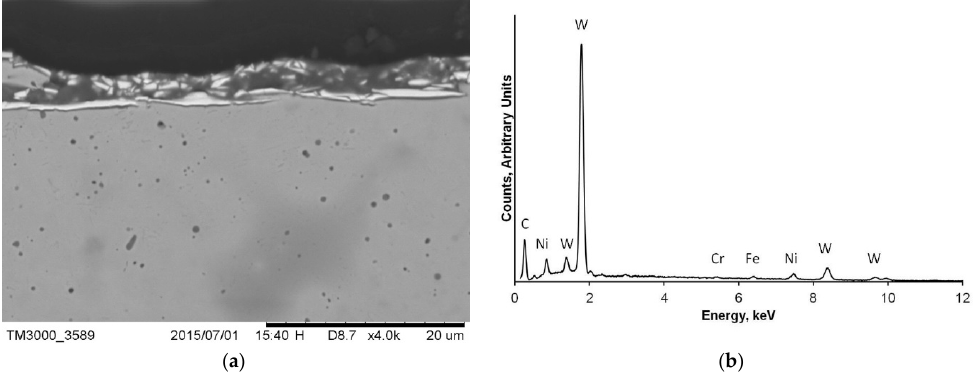
Figure 6. ( a ) Drill D section, which evidenced the tungsten carbide coating; ( b ) energy dispersive